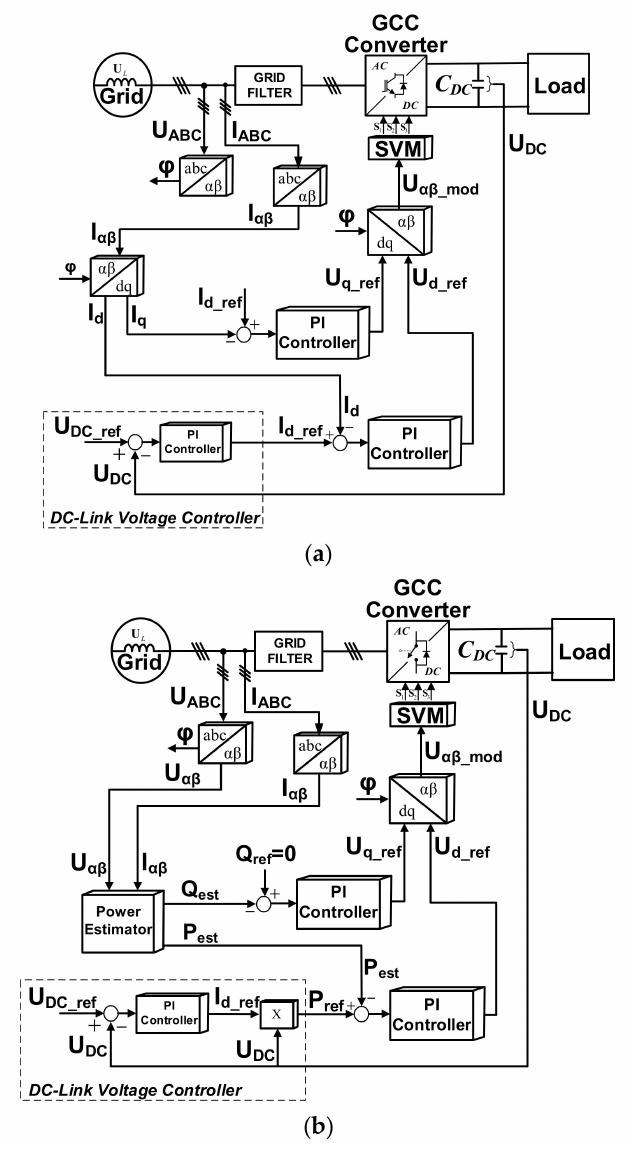
Figure 3. Regulation schemes of active AC/DC converters: ( a ) Voltage Oriented Control (VOC); ( b ) Direct Power Control with Space Vector Modulation